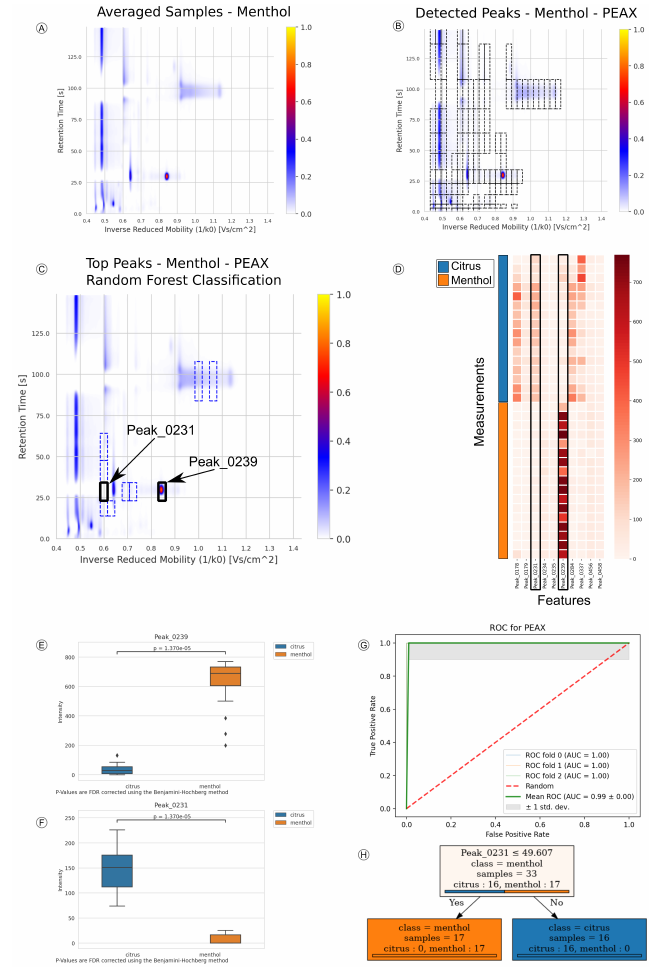
Figure 2. Stepwise results from processing the “Candy” dataset using PEAX as peak detection method. ( A ) Average normalized chromatogram for samples of class “menthol”. ( B ) Peaks detected by PEAX and aligned with Probe Clustering, overlay on average chromatogram of class “menthol”. ( C ) Top ten peaks ranked by random forest classifier. ( D ) Feature matrix of measurements used during cross-validation and model training. Columns of Peak_0231 and Peak_0239 are highlighted. ( E , F ) Boxplots of Peak_0231 and Peak_0239, intensities between “citrus” and “menthol” samples. ( G ) ROC curve during three-fold cross validation. The red line marks random performance, standard deviation is indicated. Average performance can be used to estimate actual model performance from training-set. ( H ) Decision